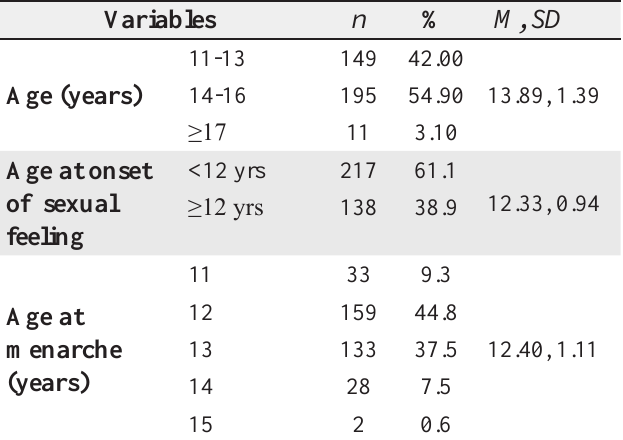
Table 2: Age distribution of adolescent girls, their sexual feeling and menarche (N=355).